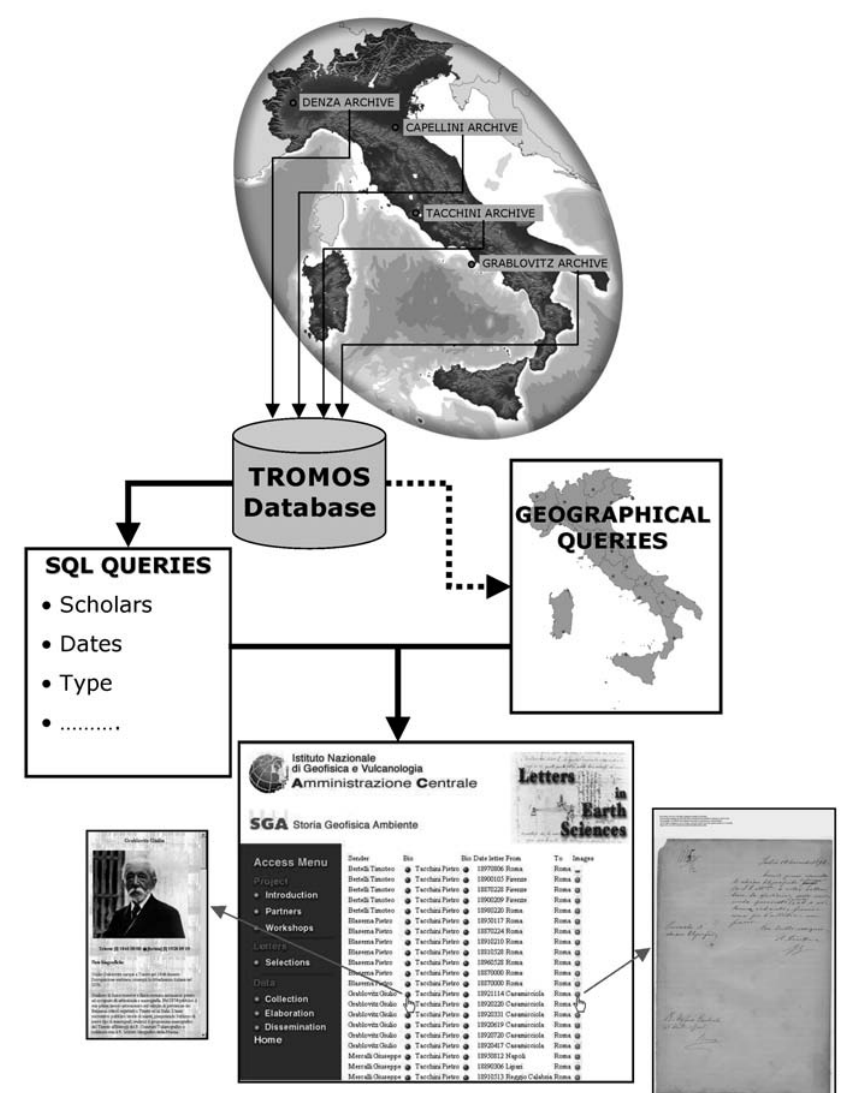
Fig. 10. Simplified scheme of the process of acquisition and dissemination materials of the project Letters in Earth Sciences. The letters processed in different forms (digital scanning, full transcription, registry) from the original place of preservation are catalogued and all the papers are added to the TROMOS database. The inter- net-based dissemination project of all the materials provides for the parametric ( i.e . the name of the correspon- dents, chronological range, type of letter and contents, etc.) as well as geographical querying of the database. The first type of querying has already been set up, while the geographical type of approach is still undergoing completion. At the bottom, an example of the outputs list. The keys to the right of the correspondents’ names refer back to their respective biographies, while the button on the far right refers back to the image of the letter and the cor- related